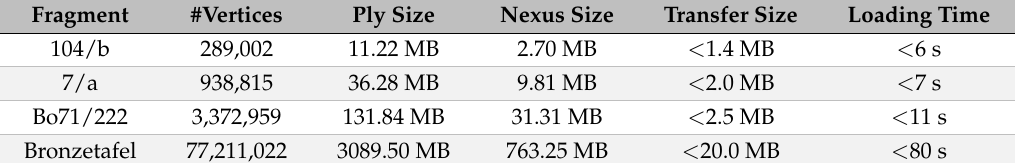
Table 2. Performance measurements on an exemplary set of four cuneiform fragments. Nexus-size denotes the size of a compressed nxs file, while loading time and transfer size refer to a measuring point, where a subset of data resulting in a usable model has been transfered on a 2000 kbit